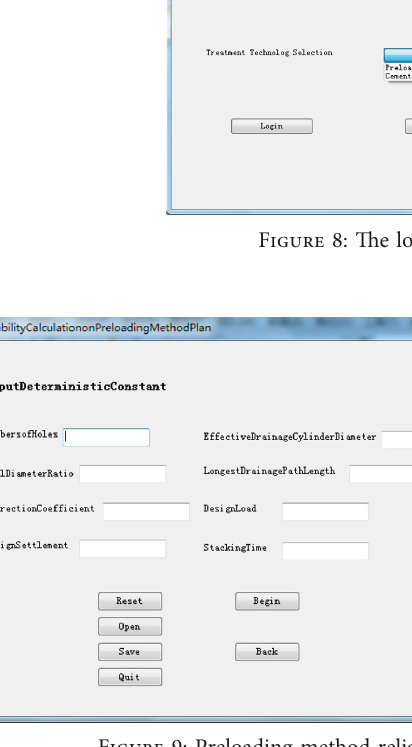
Figure 9: Preloading method reliability calculation interface.